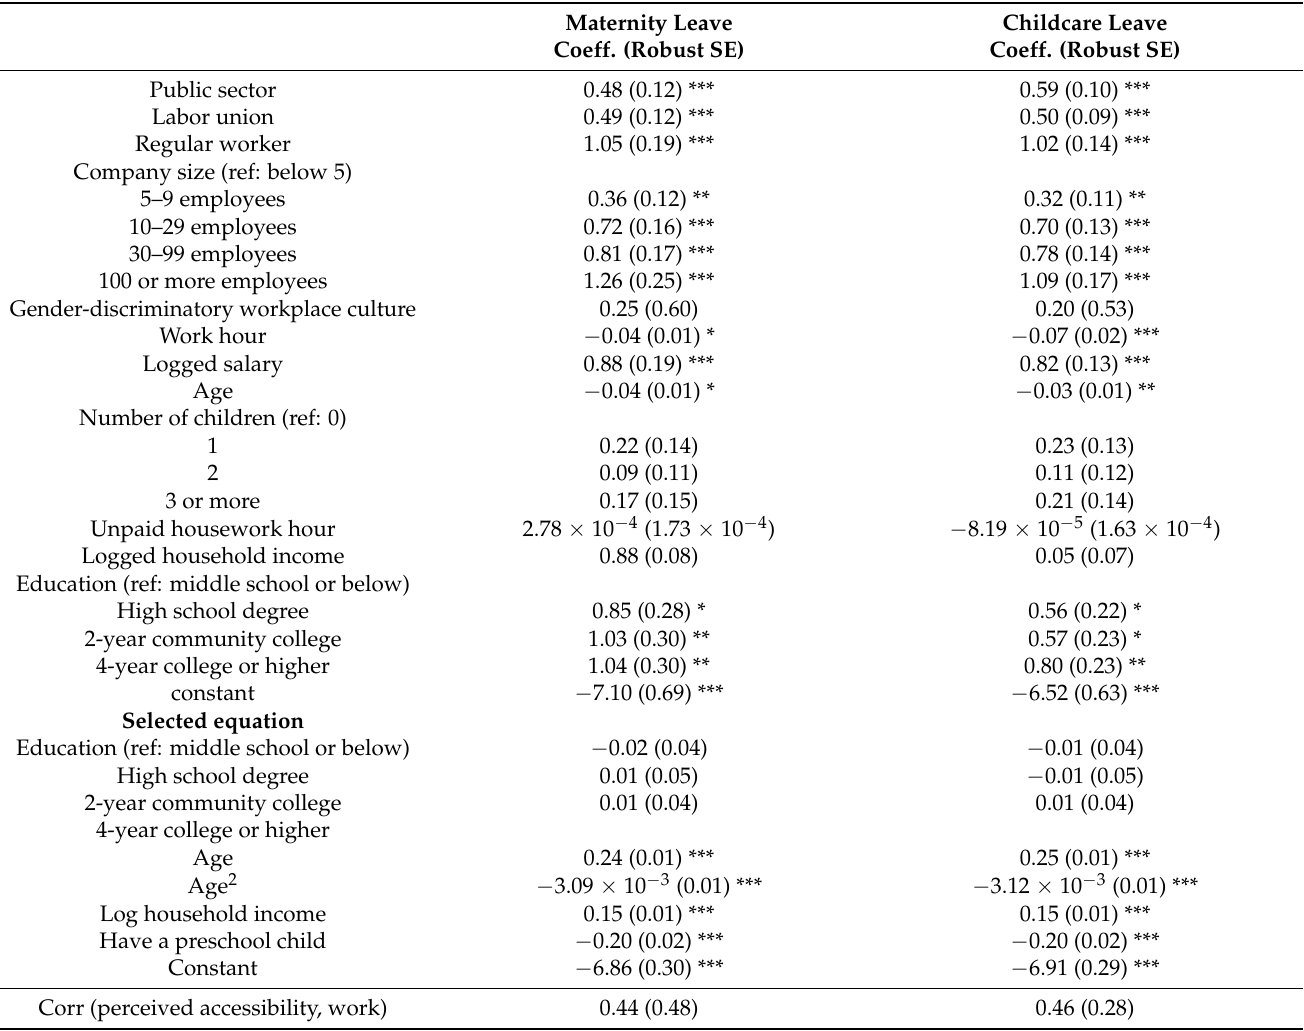
Table A1. Extended Regression Model (ERM) probit analysis controlling for selection